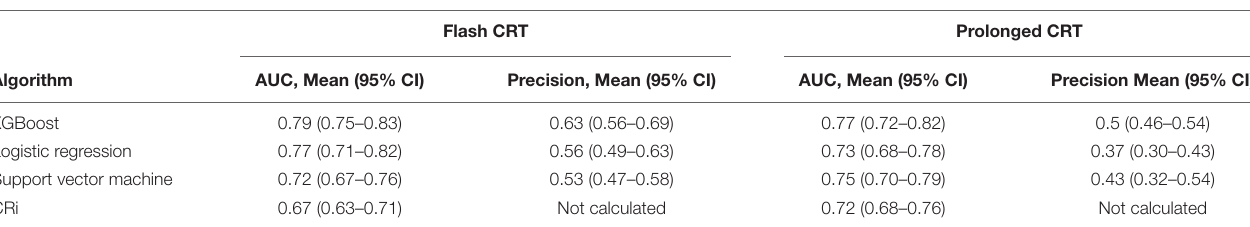
TABLE 2 | Mean Area Under the Curve and precision for each machine learning algorithm and capillary refill index. Flash CRT Prolonged